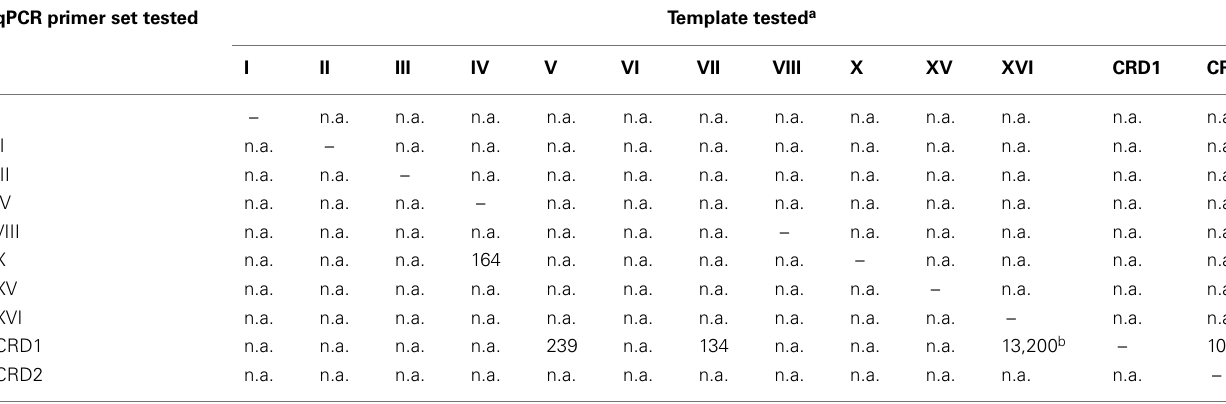
TableA3 | Level of amplification when qPCR primer sets were challenged with non-specific template. qPCR primer set